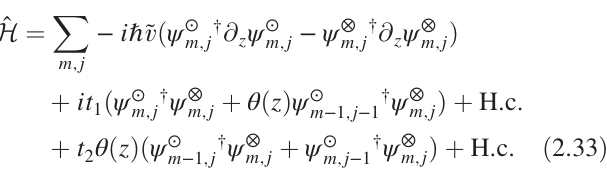
FIG. 12. Fermi arcs (blue lines) joining projected Weyl points on the surface Brillouin zones along (a) the (100) surface and (b) the (001) surface.